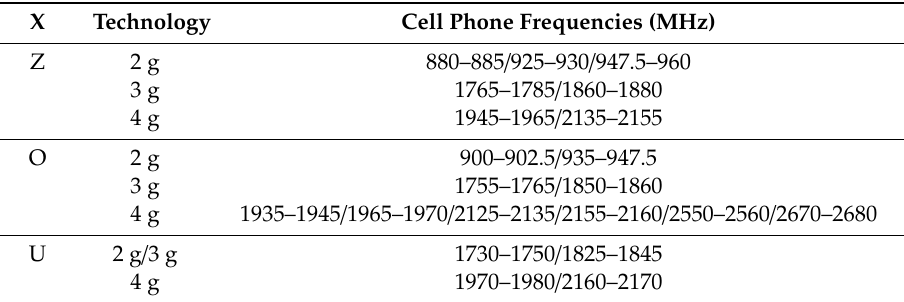
Table 2. Cell phone frequencies of each company (from spectrummonitoring.com).